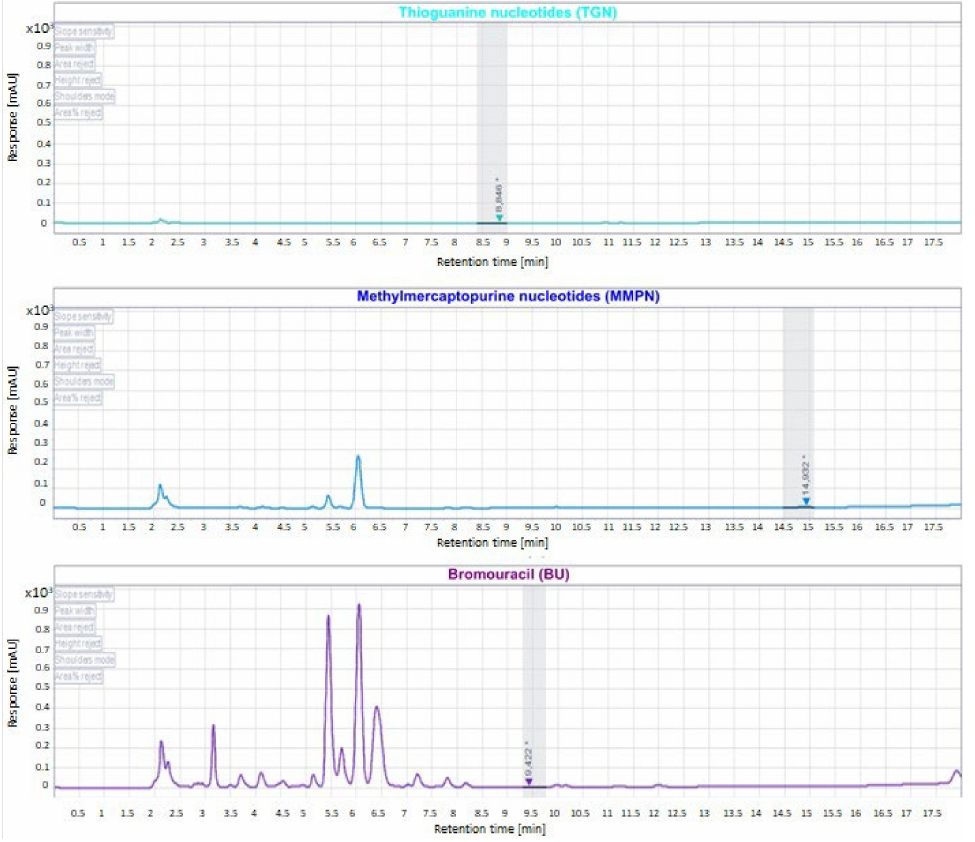
Figure 3. Chromatogram showing blank sample after the injection of CAL with the highest concen- tration. * indicates the retention